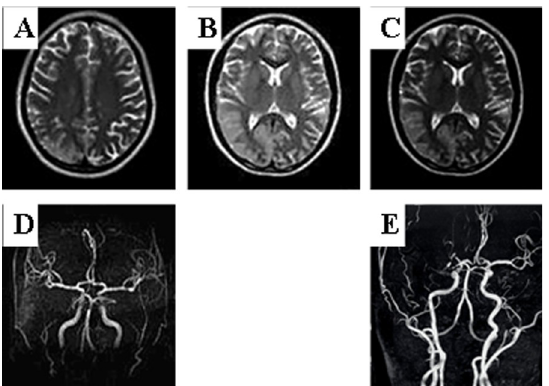
Fig 5. MRI image characteristics of cerebral infarction. Note: Fig 5A, 5C–5E referred to the MRI images of lesion, cerebral artery, degree of vessel stenosis, and vessel branches, respectively; and 5B showed a DWI image of lesion.